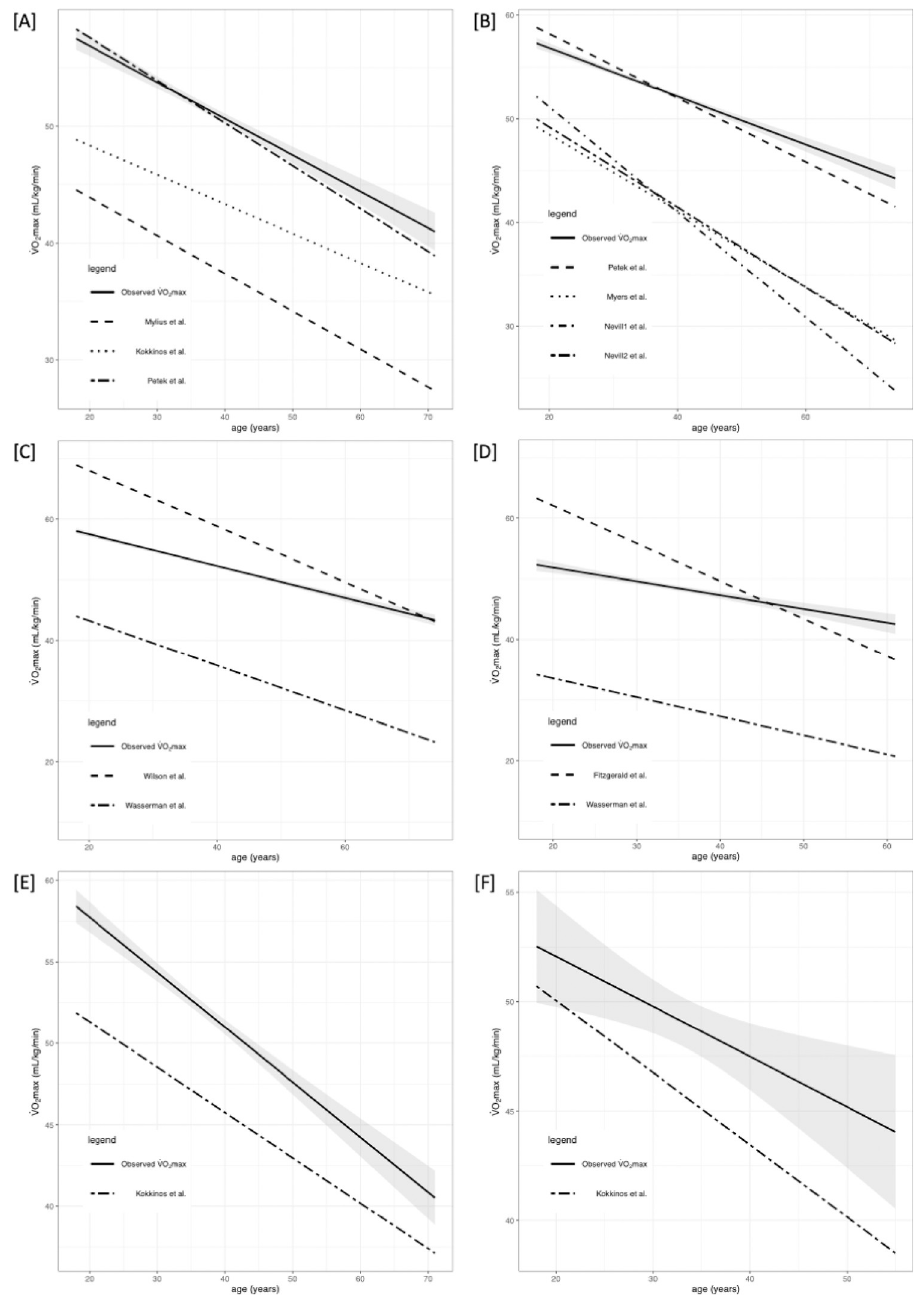
Fig 2. Regression analysis (RA) of predicted and observed VO 2max for whole population (both males and females with included „transition” group) stratified by age. 95% confidence intervals are presented with grey color. Subgroups that did not meet the TRIPOD guidelines to consider their validation results as reliable (i.e n � 100) were marked with [‡]. Abbreviations: VO 2max , maximal oxygen uptake. [A] RA for males and females for CE models; [B] RA for males and females for TE models; [C] RA for males for TE or CE models (Wilson et al. and Kokkinos et al.[1]); [D] RA for females for TE or CE models (Fitzgerald et al. and Kokkinos et al.[2]); [E] RA for males for TE or CE model (Kokkinos et al.[3]); [F] RA for females for TE or CE model (Kokkinos et al.[3]).